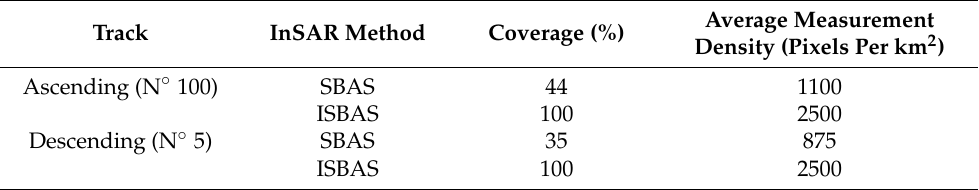
Figure 6. A comparison of the coverage between the SBAS and ISBAS methods for ( a ) ascending (track N° 100) and ( b ) descending (track N° 5) geometries for the western part of the study area. Layover and shadow areas have been excluded. Average motion derived is colour-coded, with red indicating motion away from the sensor and blue towards the sensor. Points A, B and P identify features of interest referred to in the text. Table 2. Coverage and density of ground motion measurements from the two tracks and InSAR methods across the study area, with areas of layover and shadow excluded.